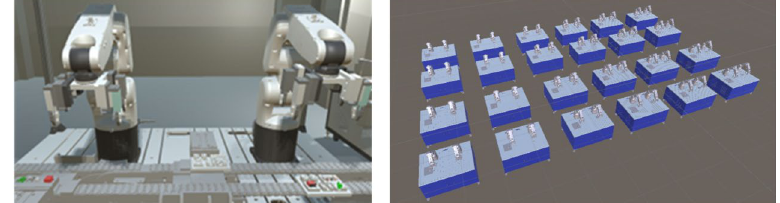
Figure 13. Two-arm cooperation robot in Unity environment.